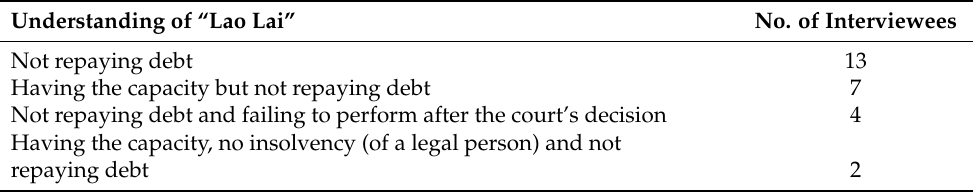
Table 4. Different understandings of the label “Lao Lai” among the interviewees. Understanding of “Lao